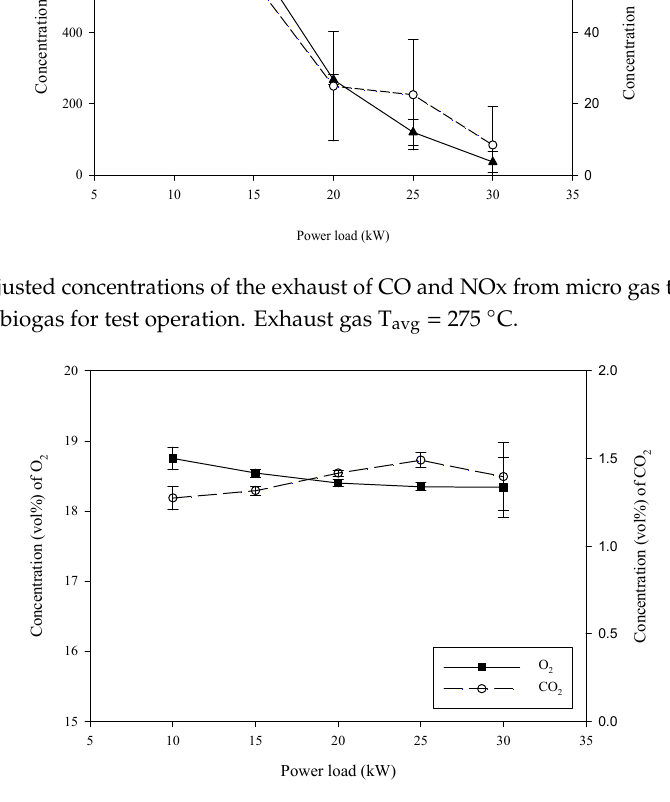
Figure 4. Un-adjusted concentrations of the exhaust of CO 2 and O 2 from micro gas turbine electricity generator using biogas for test operation. Exhaust gas T avg = 275 °C.